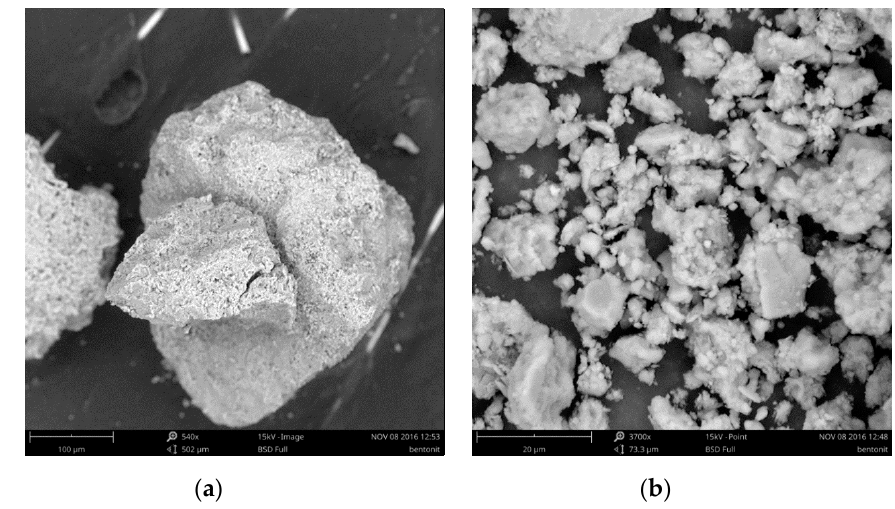
Figure 2. Scanning electron microscope (SEM) images of bentonite: ( a ) magnification of 540×, ( b ) magnification of 3700×.